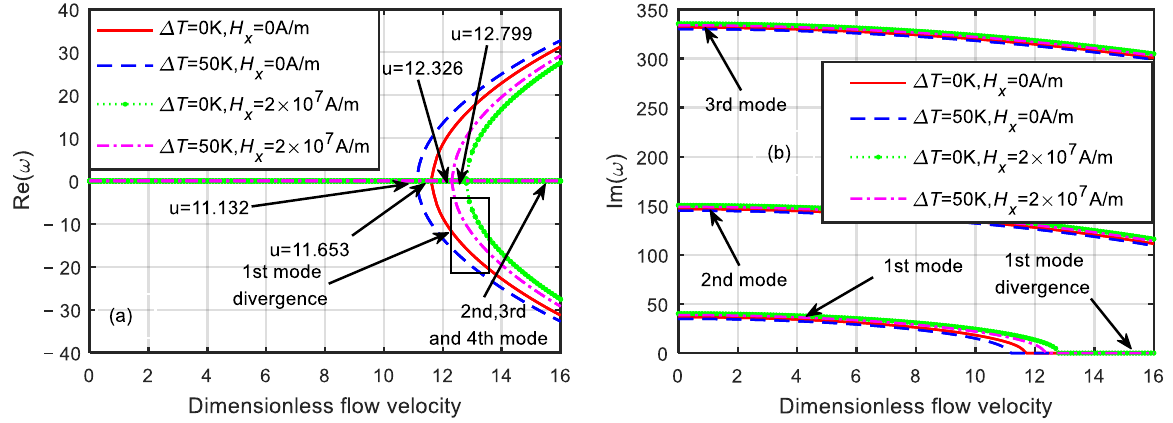
Figure 7. Dimensionless eigenfrequency variations with dimensionless flow velocity under different thermo-magnetic coupled fields ( δ = 1). ( a ) Real part. ( b ) Imaginary part.